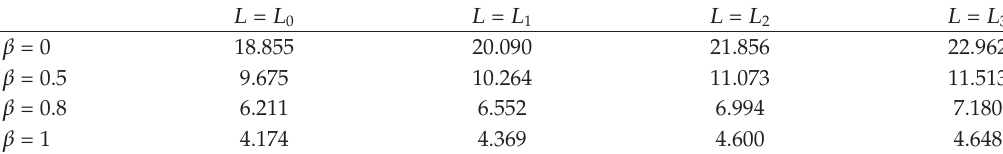
√ α (cid:7) α . 3 1 2 L (cid:6) L